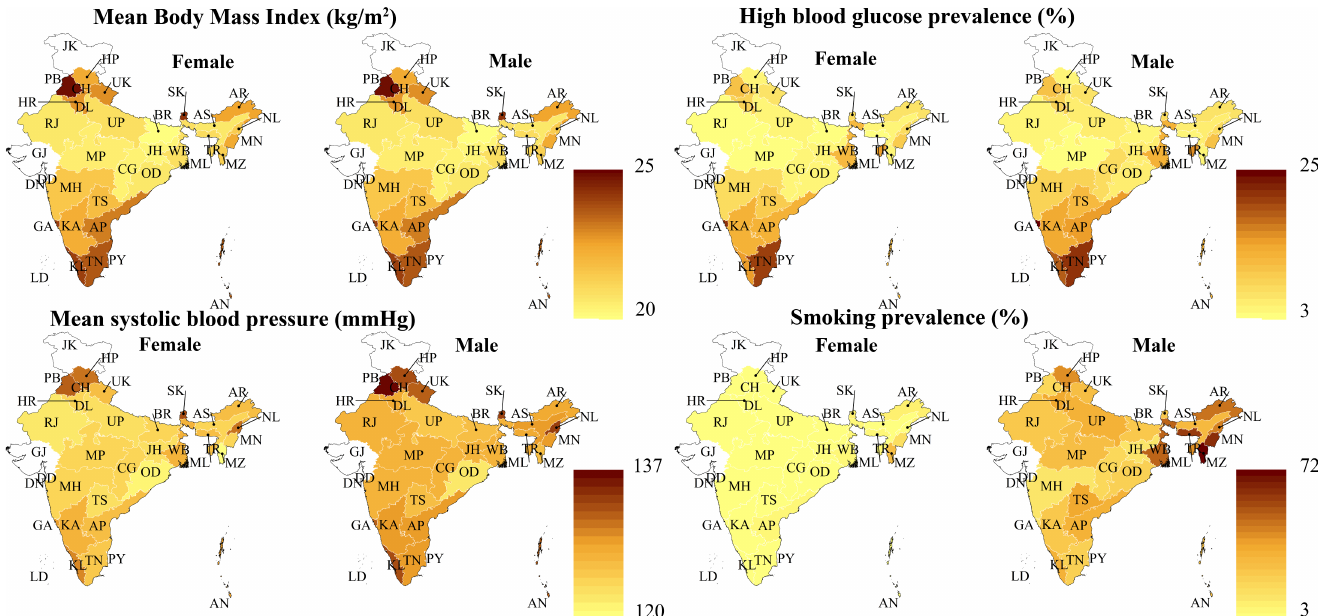
Fig 4. Body mass index, high blood glucose, systolic blood pressure, and smoking prevalence by state and sex. All outcome variables in this figure have been age- standardized using the Global Burden of Disease project’s 2013 population for India [36]. “Smoking” refers to smoking of any tobacco products but does not include chewing of tobacco. High blood glucose was defined as a high capillary blood glucose measurement ( (cid:21) 7.0 mmol/l if fasted and (cid:21) 11.1 mmol/l if non-fasted) or reporting to be on regular treatment for diabetes. AN, Andaman and Nicobar Islands; AP, Andhra Pradesh; AR, Arunachal Pradesh; AS, Assam; BR, Bihar; CG, Chhattisgarh; CH, Chandigarh; DD, Daman and Diu; DL, Delhi; DN, Dadra and Nagar Haveli; GA, Goa; GJ, Gujarat; HR, Haryana; HP, Himachal Pradesh; JH, Jharkhand; JK, Jammu and Kashmir; KA, Karnataka; KL, Kerala; LD, Lakshadweep; MP, Madhya Pradesh; MH, Maharashtra; MN, Manipur; ML, Meghalaya; MZ, Mizoram; NL, Nagaland; OD, Odisha (Orissa); PB, Punjab; PY, Puducherry; RJ, Rajasthan; SK, Sikkim; TN, Tamil Nadu; TS, Telangana State; TR, Tripura; UP, Uttar Pradesh; UK, Uttarakhand (Uttaranchal); WB, West Bengal.